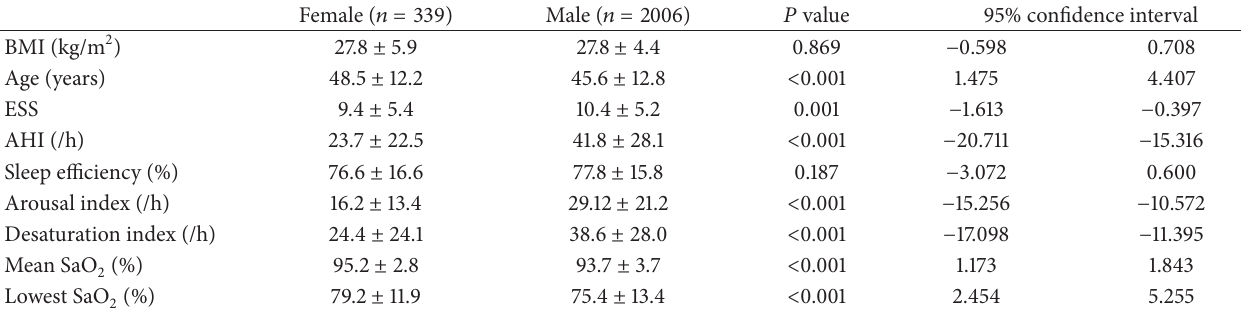
Table 1: Characteristics and polysomnographic variables of the male and female patients with obstructive sleep